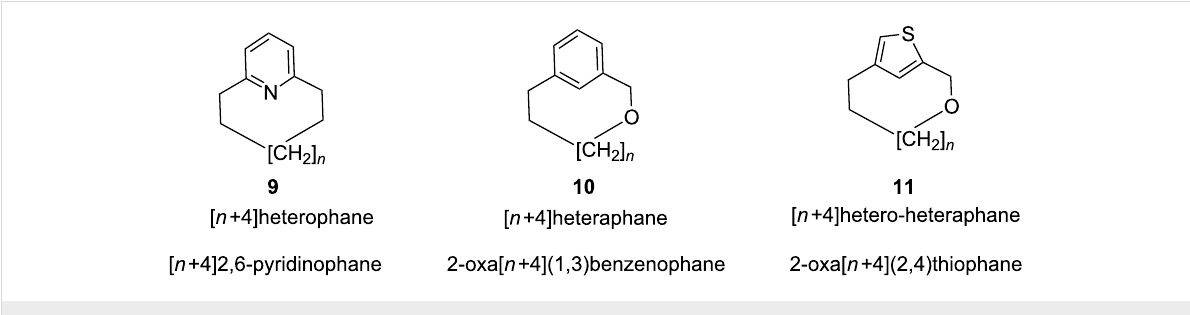
Figure 2: cyclophanes one or more with heteroatom.